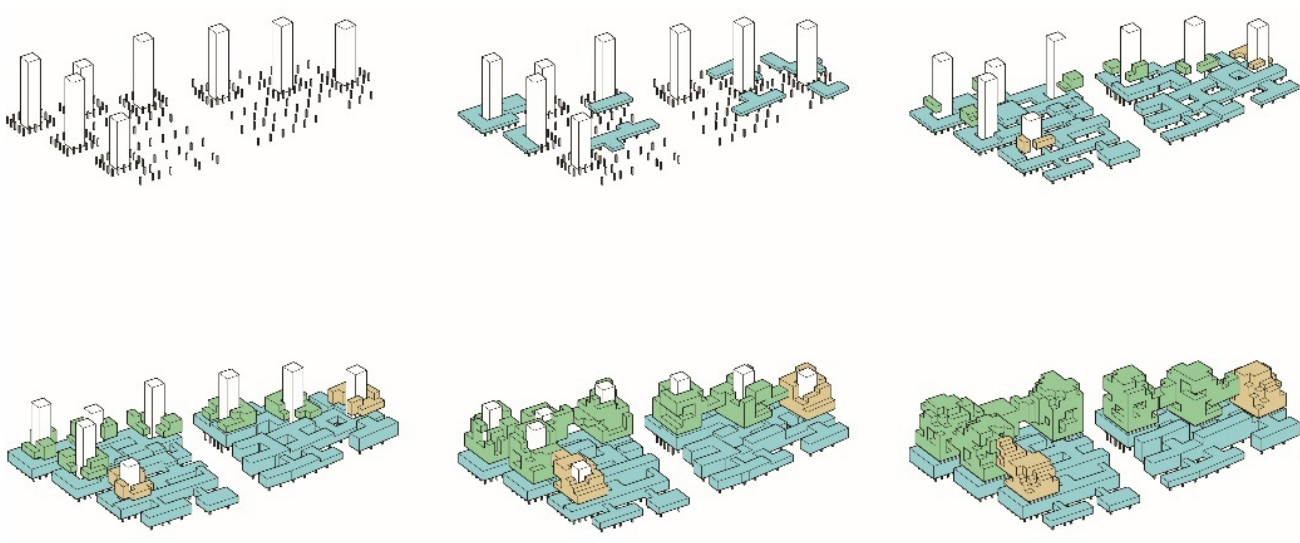
Figure 7. The process of community and building growth proposed in the author’s proposal. Here is the proposed growth process of building structure and function.